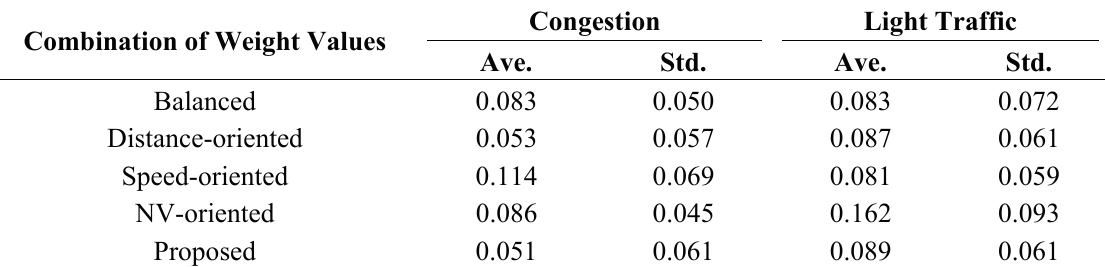
Table 10. Average error rate for combinations of weight values under the congested and light traffic